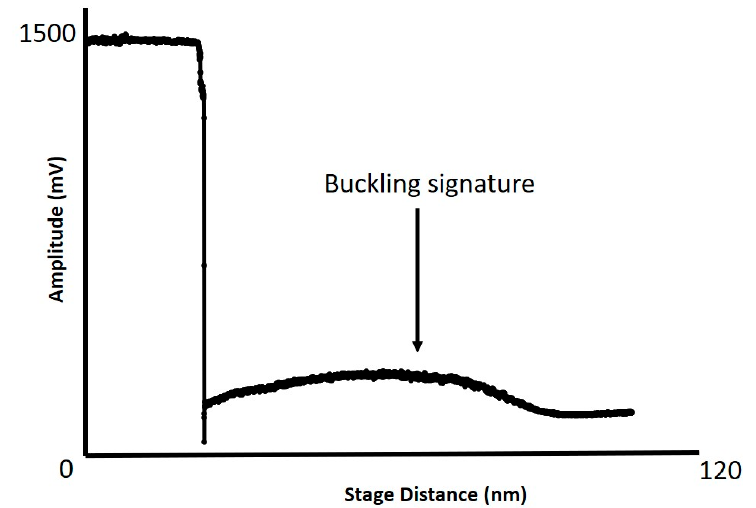
Figure 4. ( a ) exhibits unstable imaging expected due to the low spring constant of the contact mode probe (0.28 N/m). High force imaging was used to attach a CNT to the AFM tip as can be seen in in sections of the image where CNTs are visible. ( b ) shows that CNT attachment was achieved due to a stable tapping mode image of the CNT surface. The height colour scale for images is 6 nm.